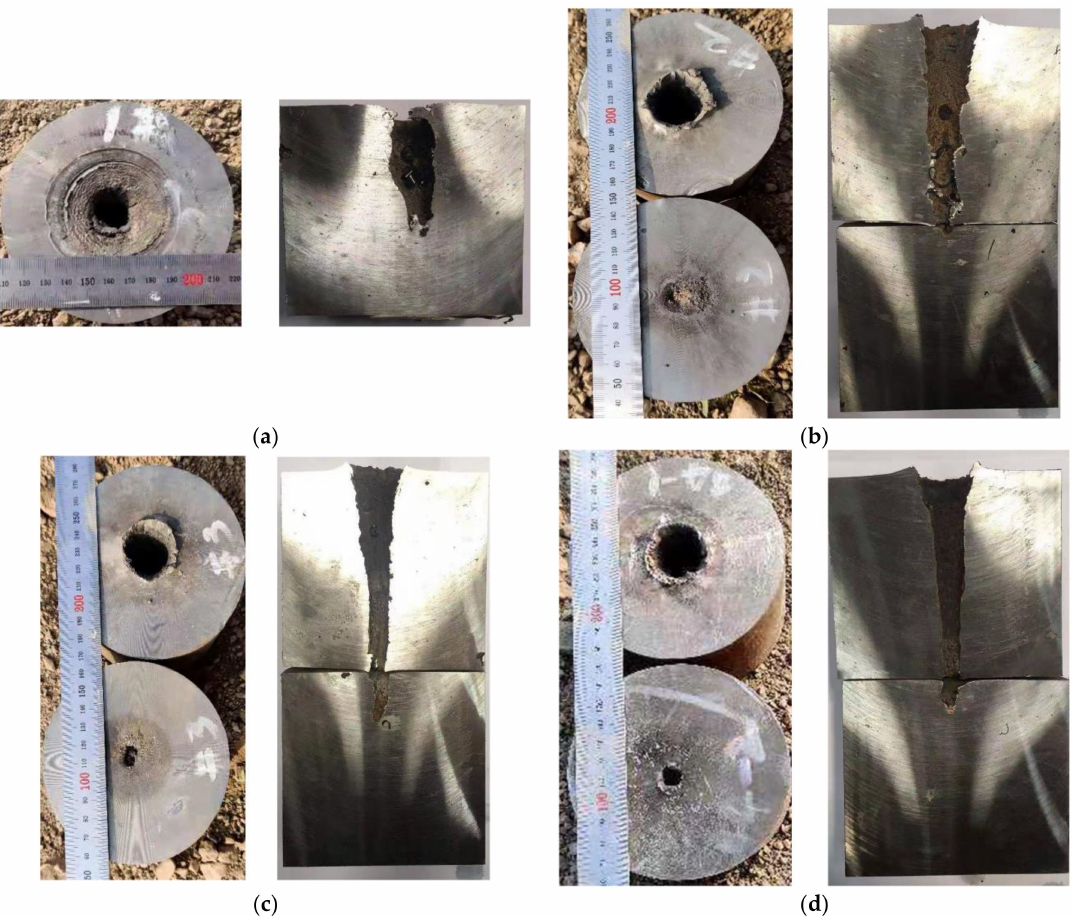
Figure 7. Experimental results of high-density reactive jets against steel targets under di ff erent stando ff s (on the left is the entrance hole view of the steel plates; on the right is a section view of the steel plates): ( a ) H = 0.5 CD; ( b ) H = 1.0 CD; ( c ) H = 1.5 CD; ( d ) H = 2.0